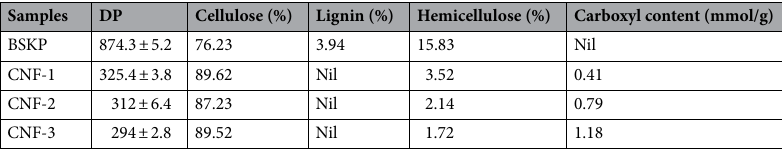
Table 1. Properties comparison and component analysis of CNFs and BSKP.